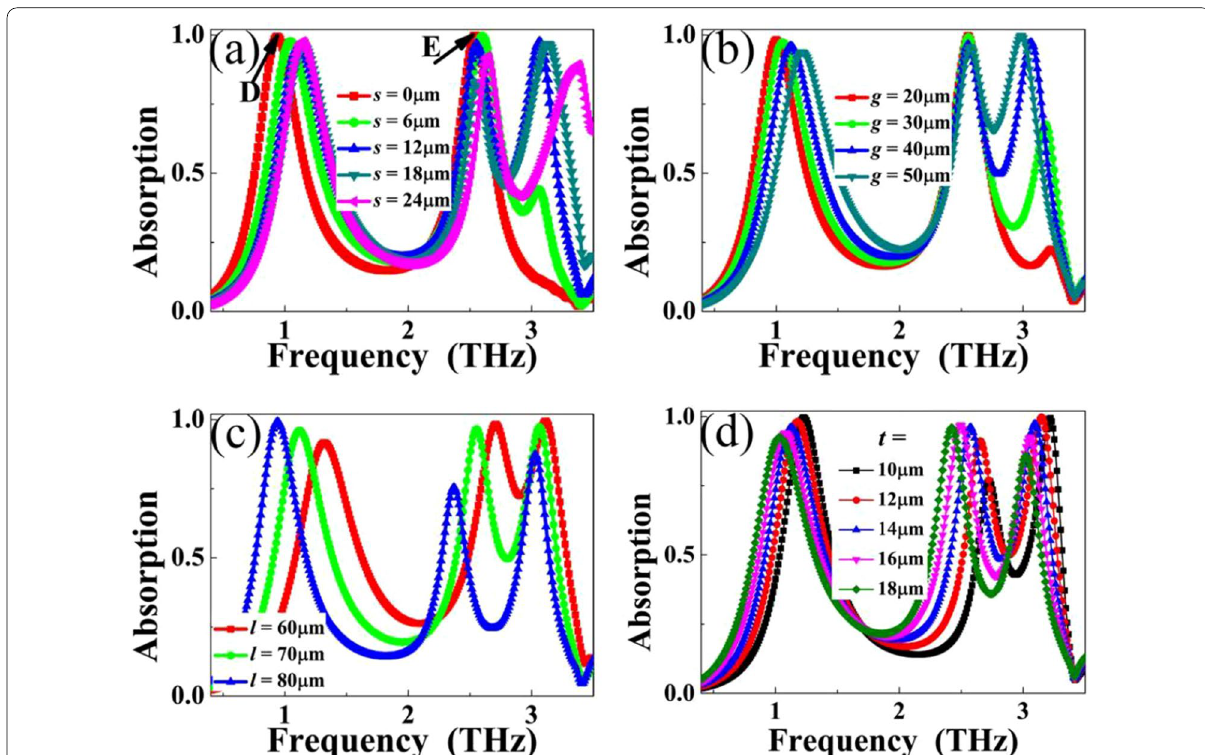
Fig. 4 Dependence of absorption spectra as a function of frequency on the parameter changes of a notch length s ; b notch width g ; c entire resonator length l ; d dielectric sheet thickness